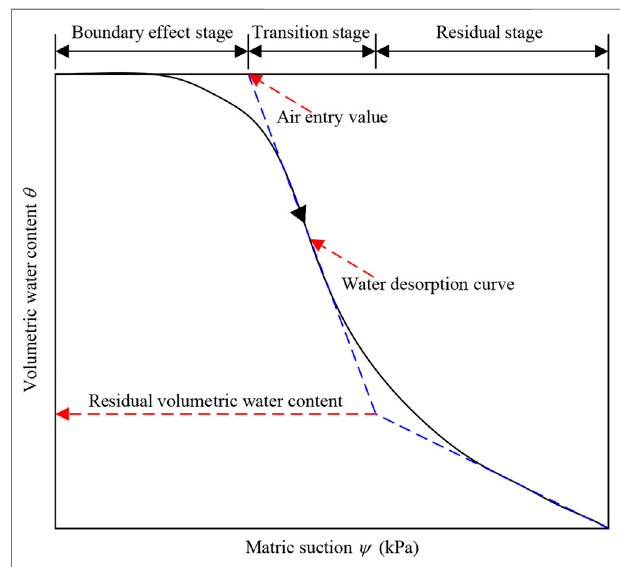
FIGURE 5 | Schematic diagram of